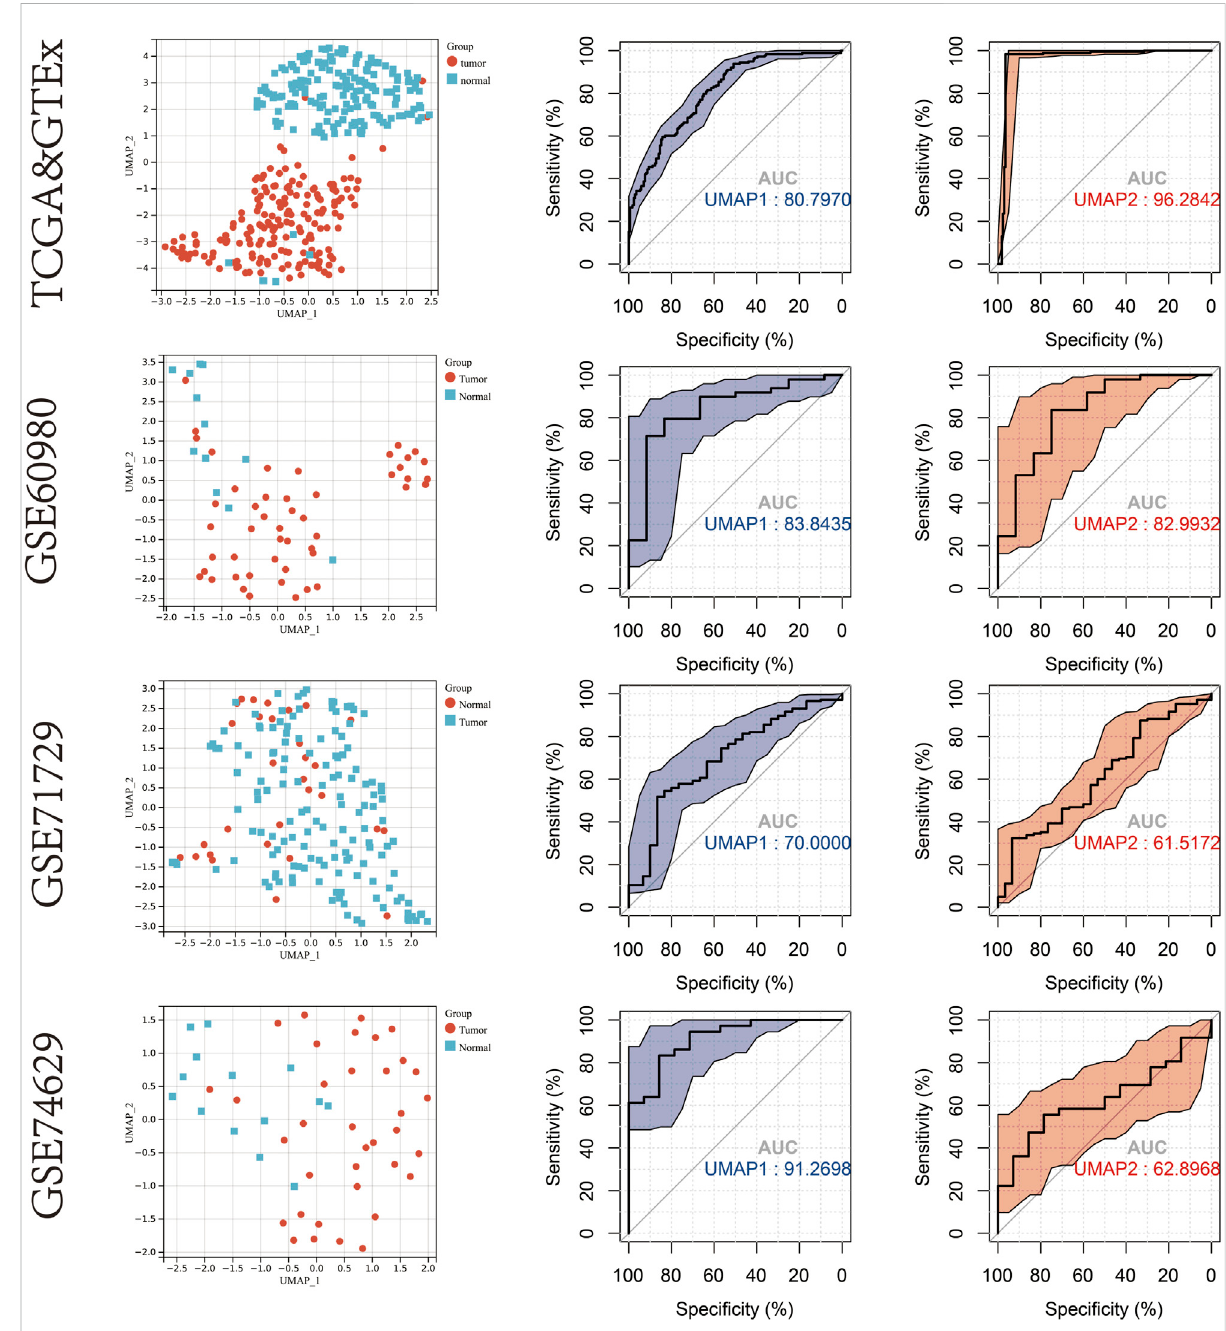
FIGURE 2 UMAP cluster representation of different mitophagy regulators expression patterns. ROC plot for diagnostic accuracy of UMAP1 and UMAP2 in TCGA & GTEx cohort,GSE60980,GSE71729 and GSE74629.